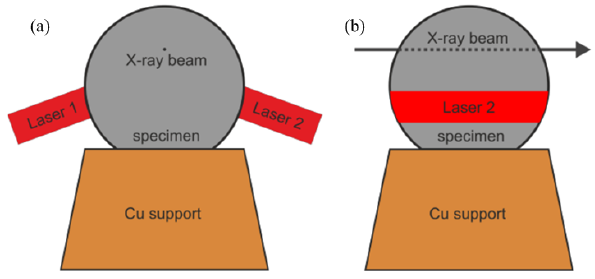
Figure 4: Measurement geometry for In situ microXRD combined with laser heating. Schematic view (a) parallel and (b) perpendicular to the incoming x-ray beam